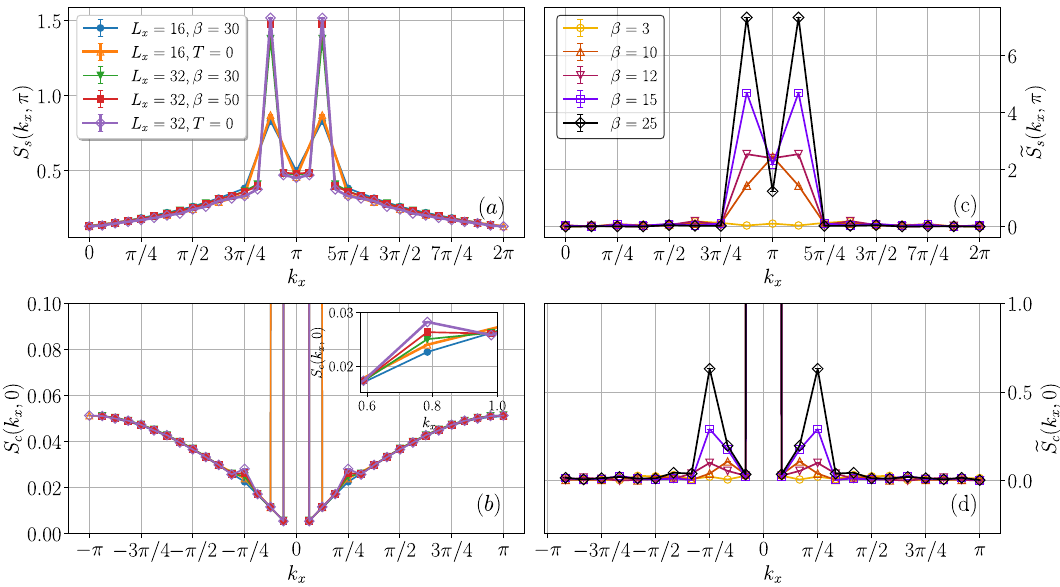
FIG. 12. Spin and charge structure factors under the two different approaches, fully PBC versus pinning field calculations. The left column shows (a) spin structure factor S s ð k x ; π Þ and (b) charge structure factor S c ð k x ; 0 Þ versus momentum k x on 16 × 4 and 32 × 4 lattices with PBC applied in both directions, for two finite (low) temperatures, compared to the corresponding ground-state result. The right column shows the Fourier transforms of the (c) spin density 32 × 4 lattice, for a sequence of temperatures. U ¼ 8 and δ ¼ 1 = 8 are used in all